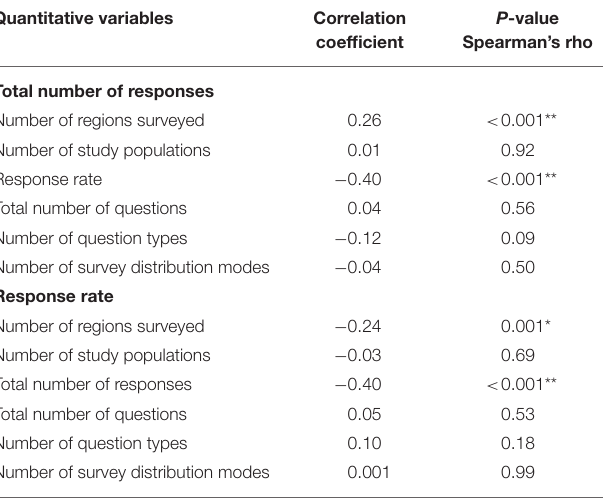
TABLE 2 | Correlation between total number of responses or response rates and TABLE 3 | Response rates across various study quantitative independent variables. Quantitative variables Correlation coefficient